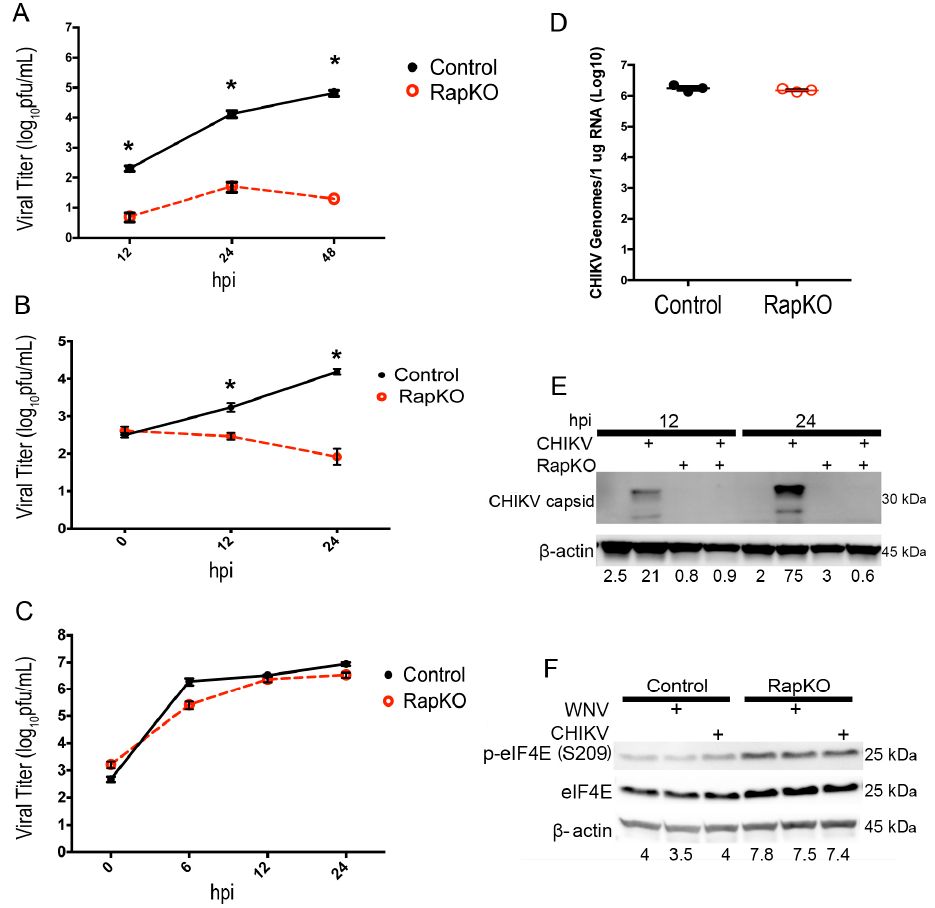
Figure 2. Raptor expression supports the growth and protein expression of 5 ′‐ capped RNA viruses. ( A ) Multi-step growth curve (MOI = 0.001) of West Nile virus (WNV) in control and Raptor knockout (RapKO) cells. N = 6 replicates per time point, * p < 0.0001; a single-step growth curve (MOI = 3) is shown for ( B ) Chikungunya virus La Reunion 2006 OPY-1 (CHIKV-LR) and ( C ) encephalomyocarditis virus (EMCV) in control and RapKO cells as determined by standard plaque assay of the supernatant. The viral titer is presented as log10 pfu/mL at indicated times (hours post-infection (hpi)). N = 6 replicates per time point, * p < 0.005; ( D ) Cell-associated CHIKV-LR genome copies in RapKO and control murine embryonic fibroblast (MEF) cells at 0 hpi determined by quantitative reverse ‐ transcriptoin PCR (qRT ‐ PCR). Data are presented as log10 CHIKV ‐ LR genomes/ μ g of RNA; ( E ) Western blot (WB) analysis of CHIKV ‐ LR protein synthesis in RapKO cells. Cellular lysates were harvested at the indicated time (hpi), normalized for total protein and subjected to WB analysis using antibodies to CHIKV capsid protein and a β‐ actin loading control. Images are representative of two independent experiments. Densitometry values are provided for CHIKV capsid corrected for β -actin expression; ( F ) Expression of phospho-eIF4E (serine 209), total eIF4E and β -actin in control and RapKO cells as determined by Western blot analysis. Total protein lysate was collected from cells either mock, WNV or CHIKV-LR infected (MOI = 3), separated by gel electrophoresis and probed for the indicated antibody targets. Images are representative of two independent experiments. Densitometry values are provided for p-eIF4E expression corrected for β -actin